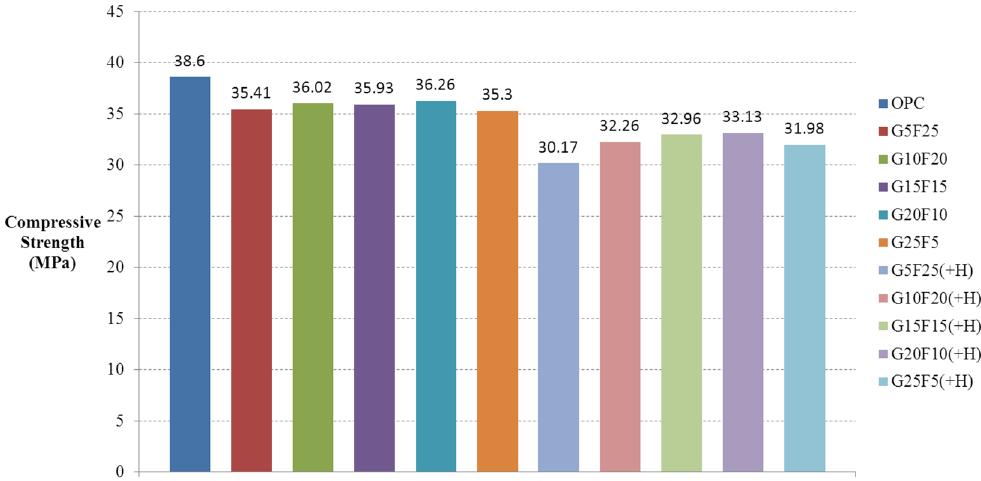
Figure 5. Compressive strength test results (W/B 45%).